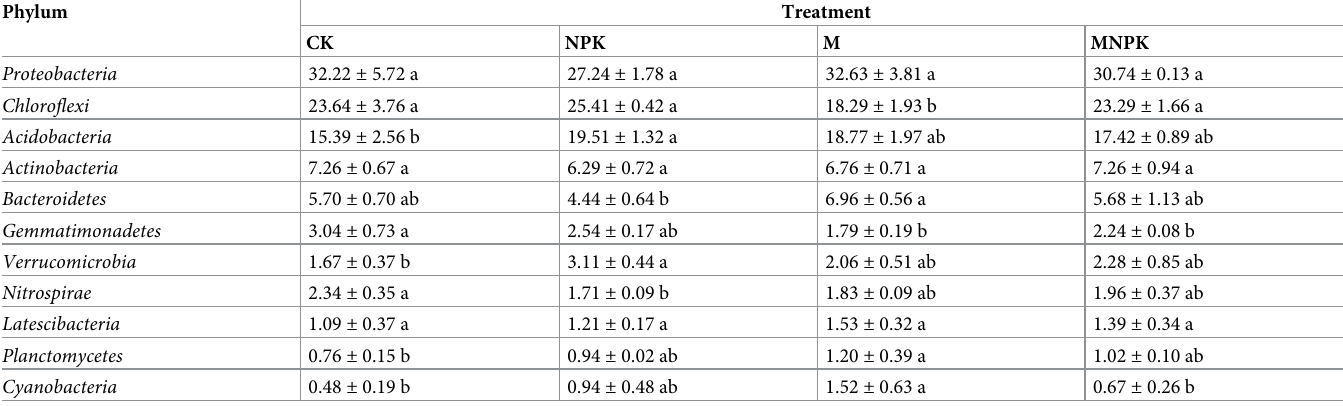
Table 4. Bacterial relative abundance on the Phylum level under different fertilization treatment (%).